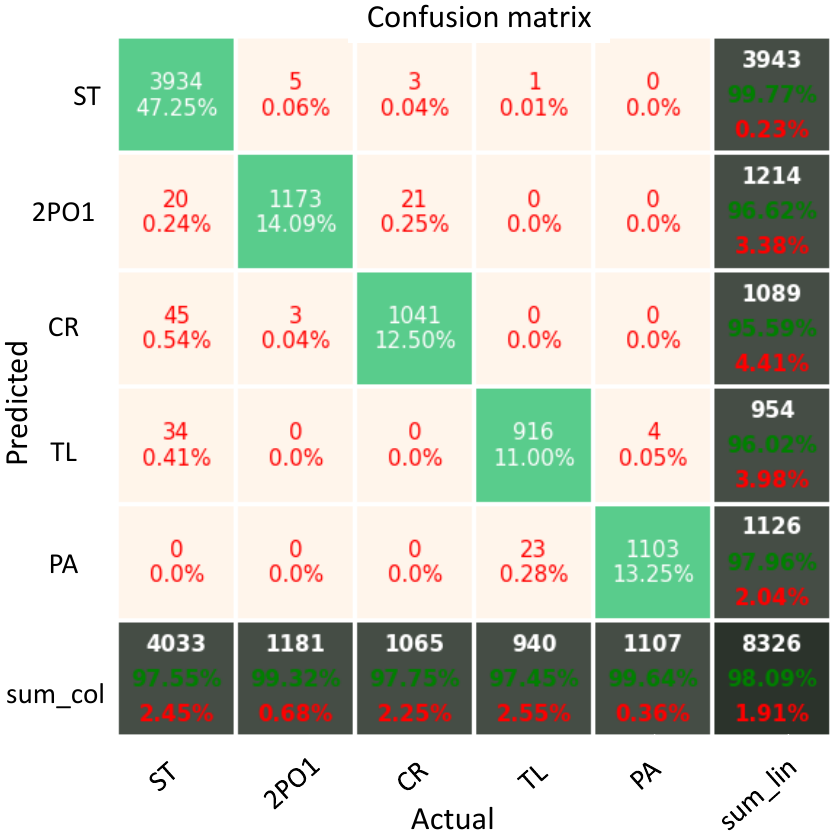
Figure 2. Confusion matrix of the room retrieval classification. These results were obtained by using the trained CNN and the augmented dataset of images captured with cloudy illumination. The rows define the real room of the images and the columns the prediction addressed by the